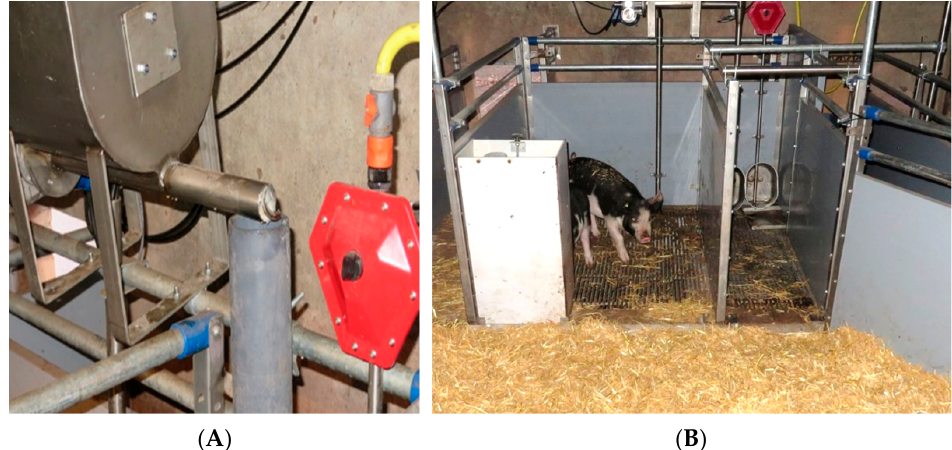
Figure 1. ( A ) Automatic rewarding system consisting of a tank for the organic lemon candy and organic sugar, feed snail and pipeline system above the urination area of the pig toilet; ( B ) pig toilet with defaecation area ( left side) and urination area with overflow drinker and rewarding system ( right